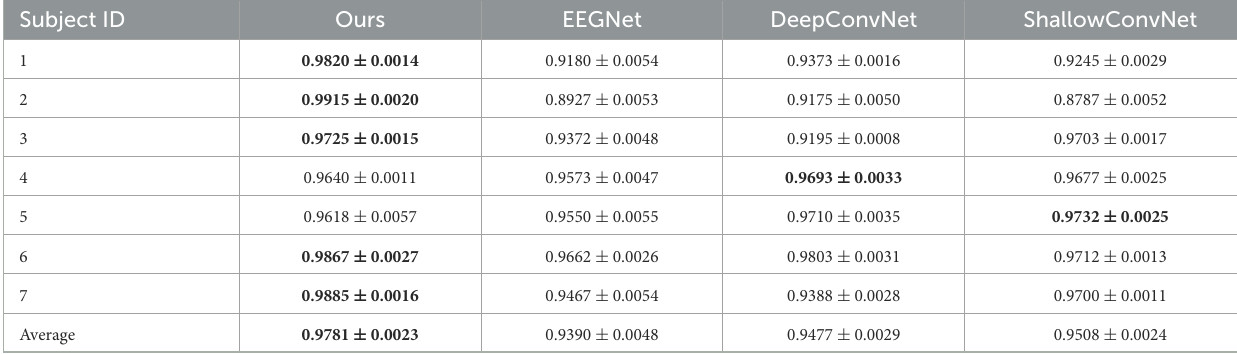
TABLE 3 Decoding performance on facehouse dataset of each subject, the best results in each domain are